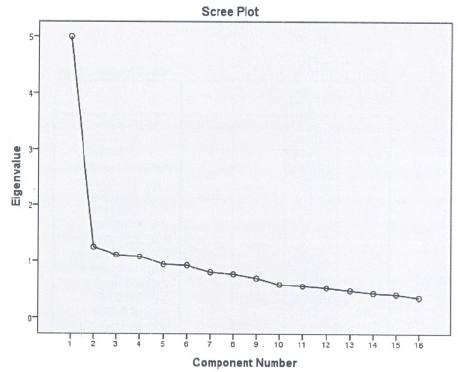
Fig. 2. The summary of Scree